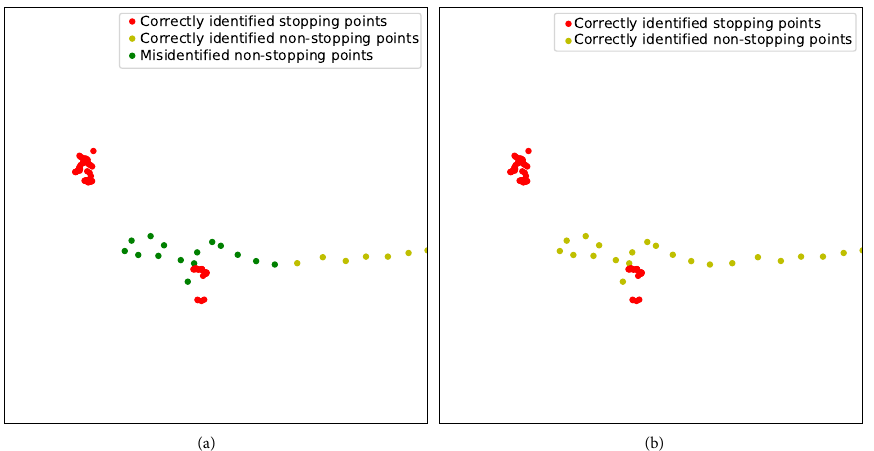
Figure 8. The local stopping point extraction results of the track 6 trajectory: ( a ) one-step DPCC-TE, ( b ) two-step